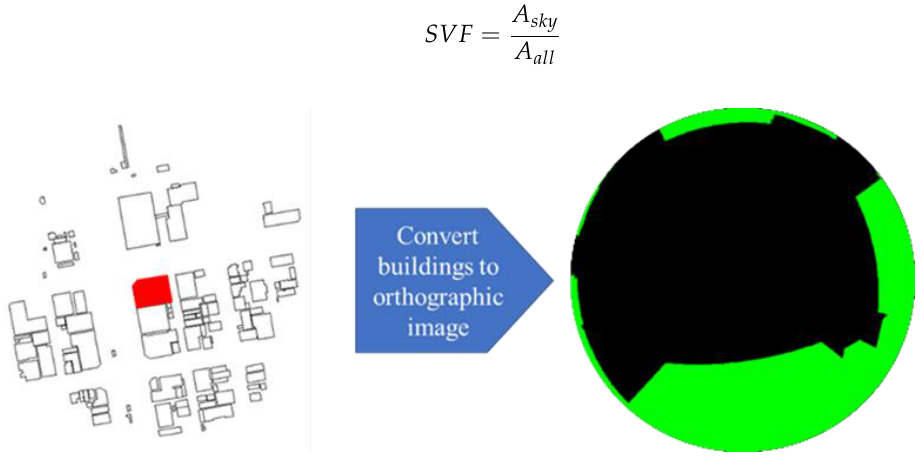
Figure 4. Buildings converted to orthographic image.